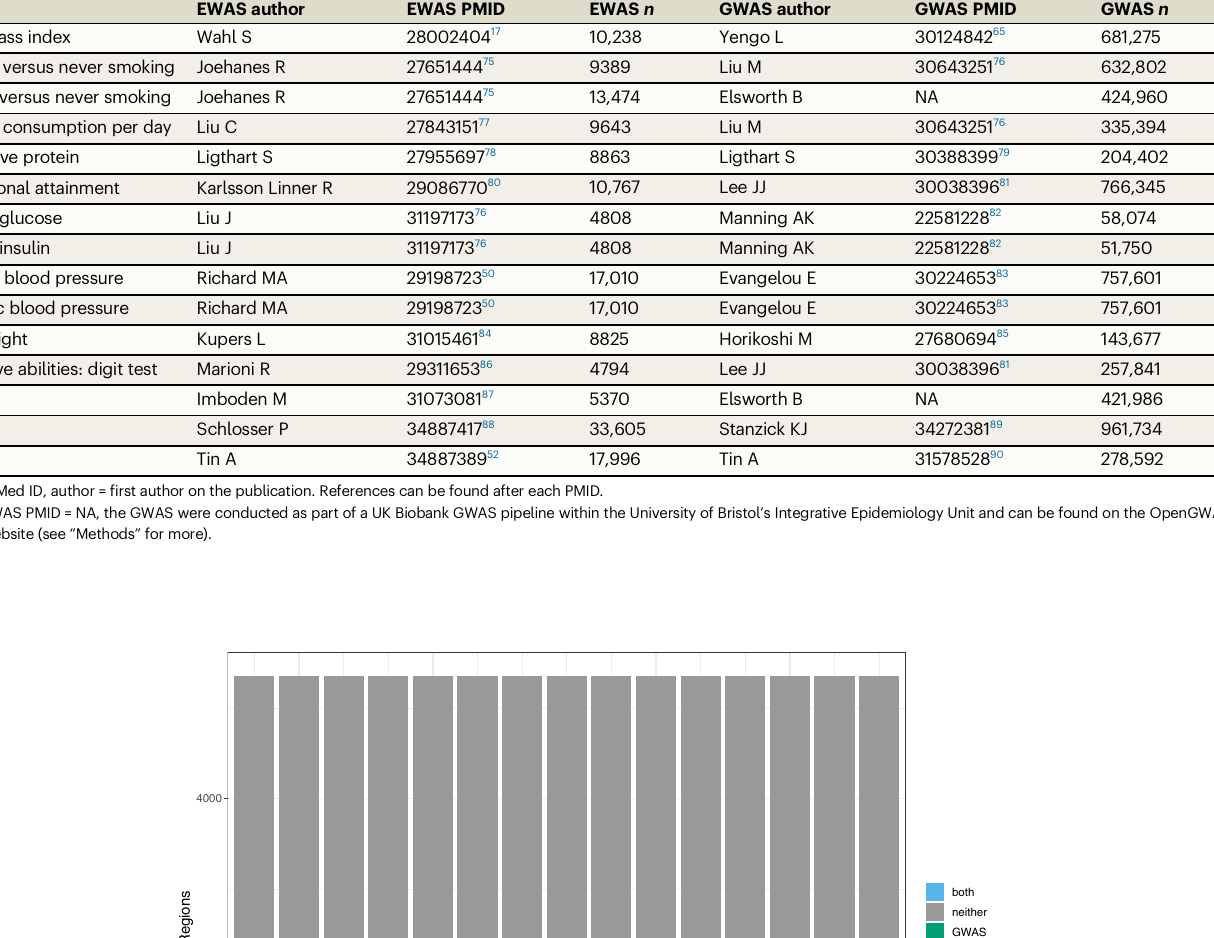
EWAS = EWAS sites only were identi fi ed, Both = Both GWAS and EWAS sites